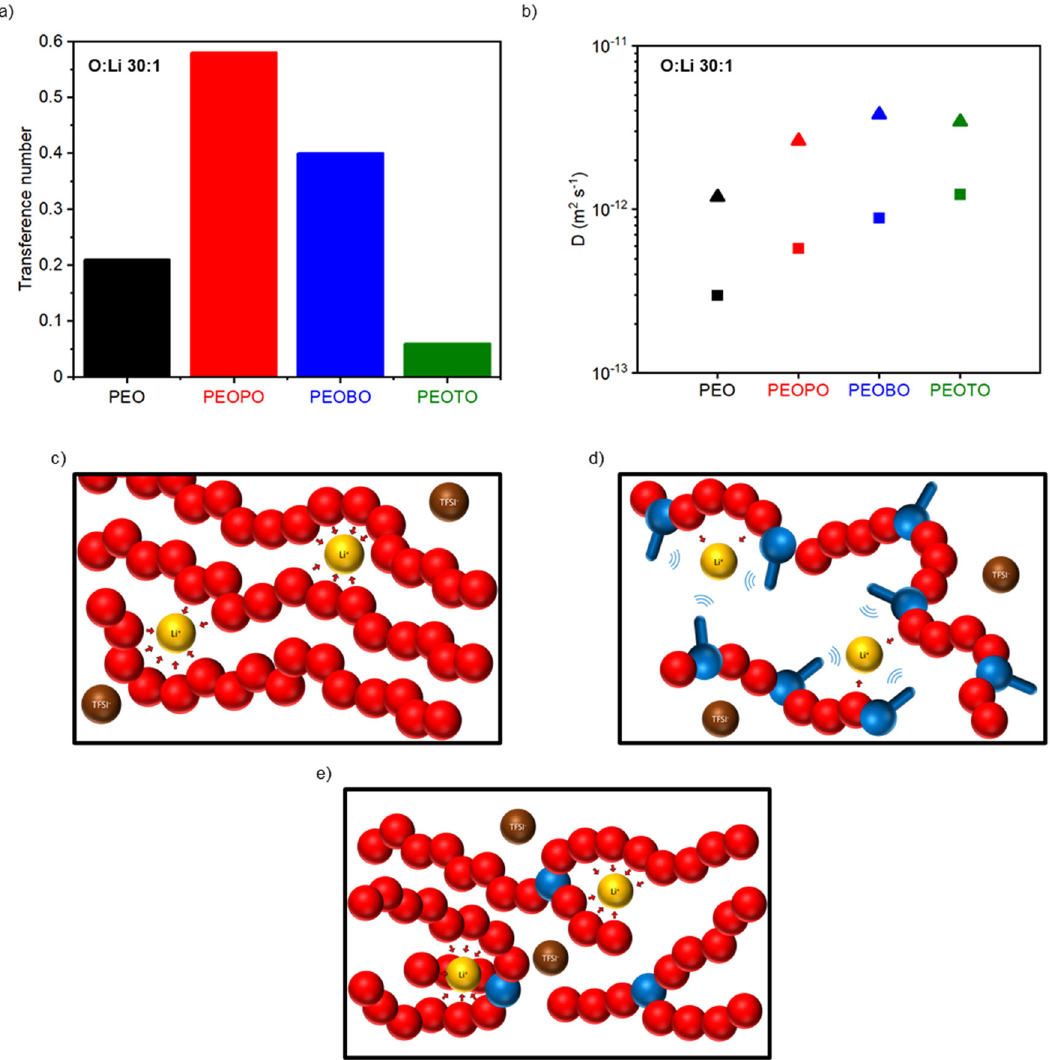
Fig. 4 Characterization of the ionic transport. a Cationic transference numbers of statistical copolymers (10 mol% comonomer) obtained by the Bruce – Vincent method at 25 °C. b Self-diffusion coef fi cients obtained by PFG-SSNMR (square for lithium and triangle for fl uorine). Schematized representation of the coordination of Li + (yellow sphere) c in polyethylene oxide (PEO), d in copolymers of ethylene oxide with propylene oxide (PEOPO, comonomer unit in blue) and e in copolymers of ethylene oxide with methyl ether triethylene glycol glycidyl ether (PEOTO).